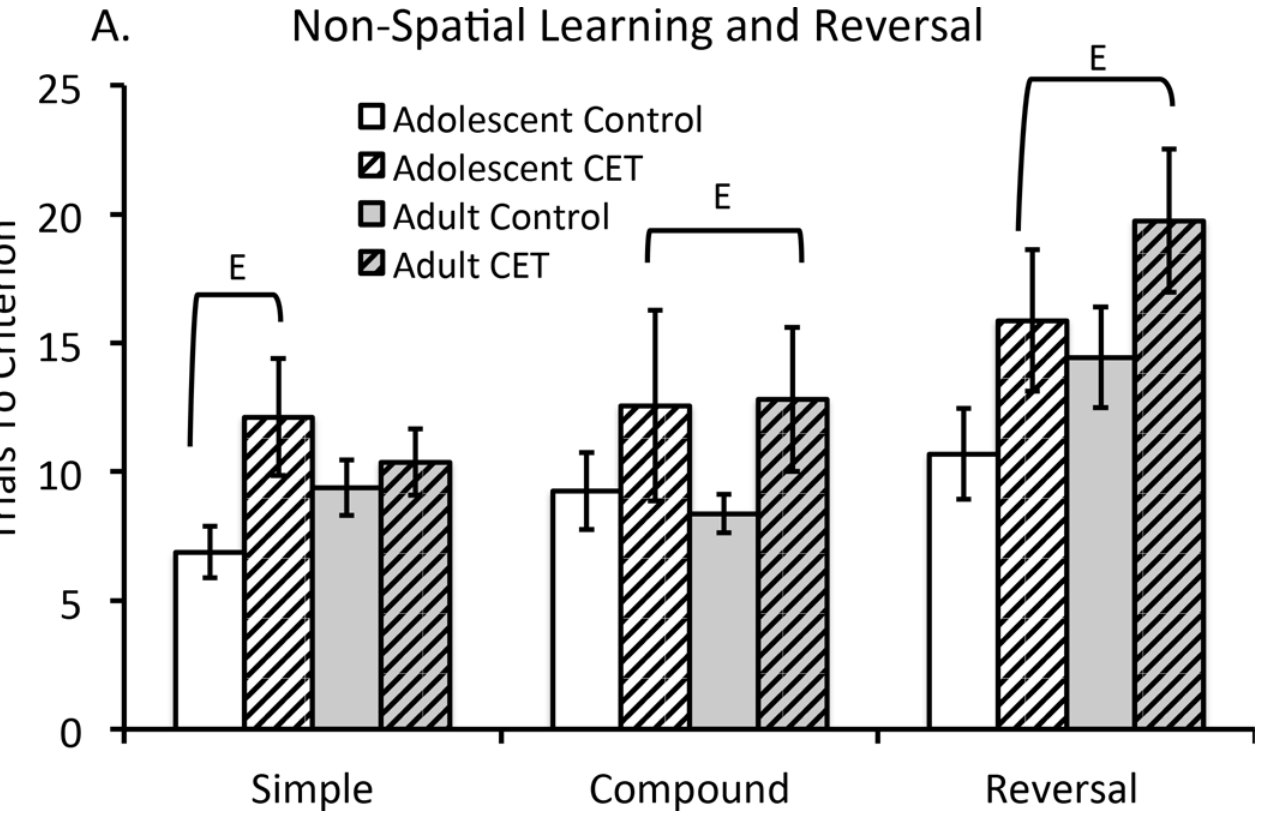
Fig 8. Chronic EtOH drinking, regardless of age of drinking onset, impaired complex non-spatial discrimination learning and reduced behavioral flexibility. (A) The average number of trials required to reach criterion during non-spatial discrimination learning and reversal tasks. Criterion was defined as making a correct discrimination on 6 consecutive trials. Significant CET effects [E] were found on the simple discrimination task, compound discrimination and reversal phases. In these three tasks, CET rats all required more trials to reach criterion compared to controls (E, p ’ s <